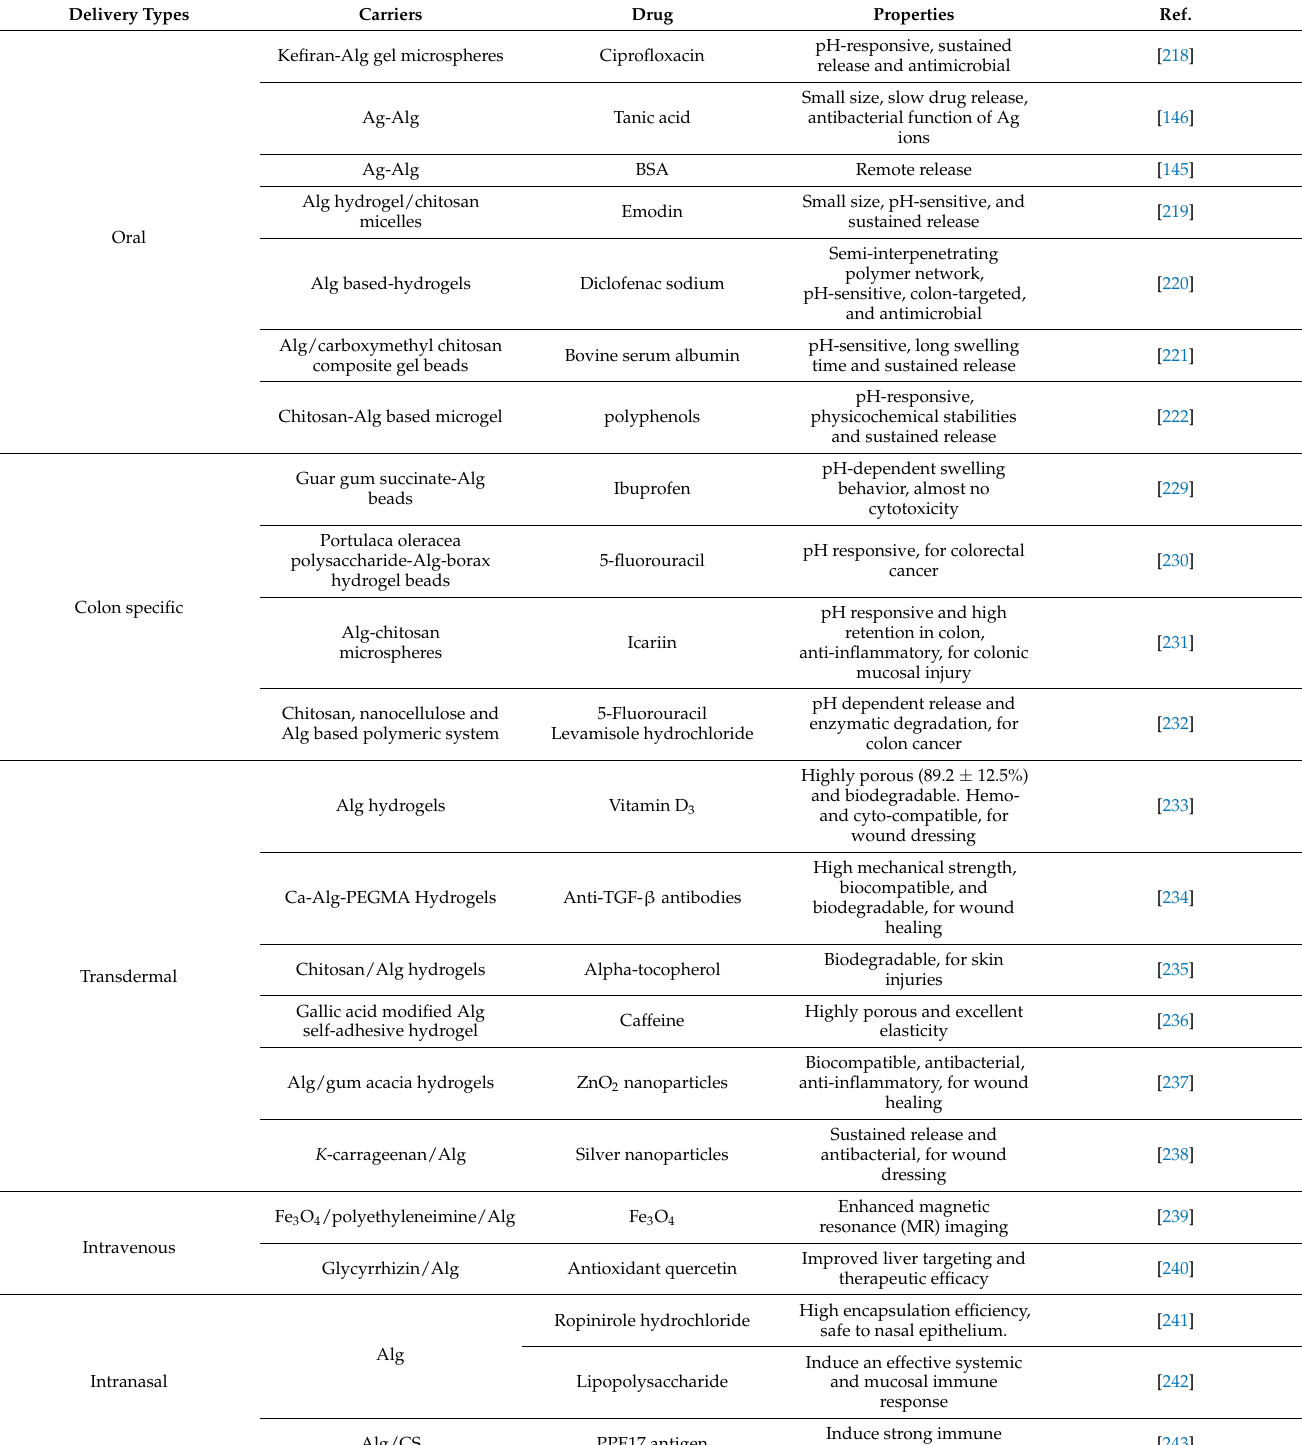
Table 5. Various Alg-based hydrogel carriers used in drug